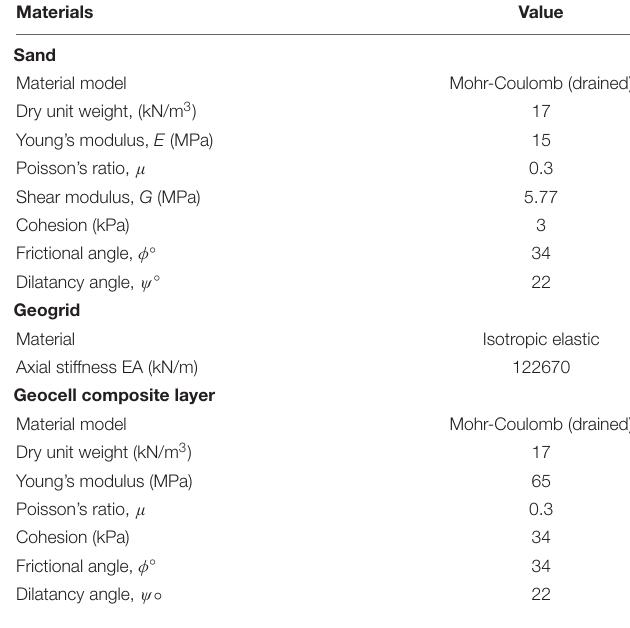
TABLE 4 | Materials properties used in PLAXIS 2D